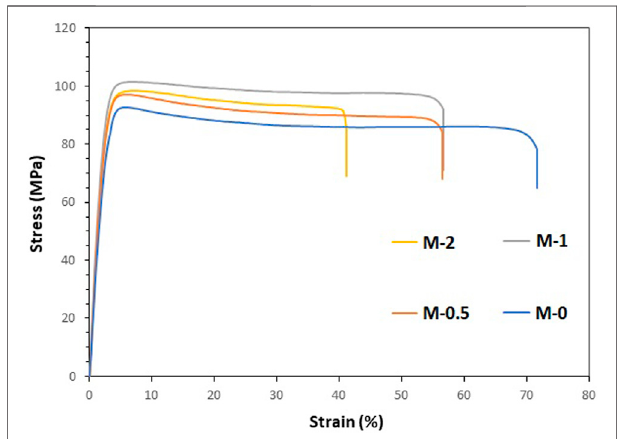
FIGURE 5 | Stress-strain curve for injection moulded PEEK samples containing 0, 0.5, 1, and 2wt% IF-WS 2 .